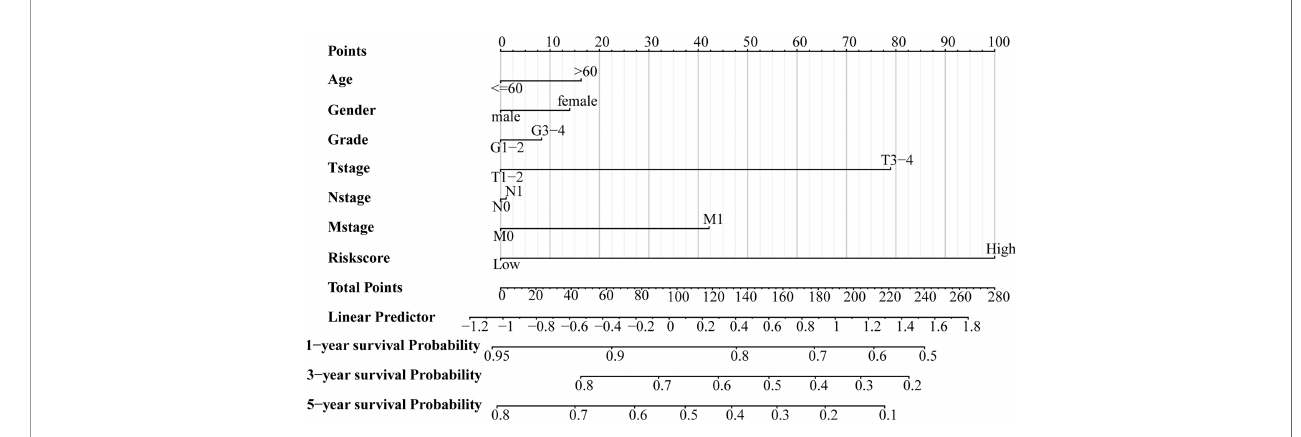
FIGURE 5 | A prognostic nomogram for the overall survival of patients with